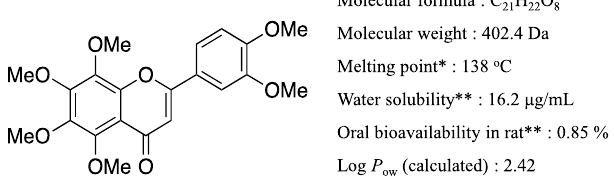
Figure 1. Chemical structure and physicochemical properties of NOB. * Chen et al . 18 , ** Onoue et al . 11 .